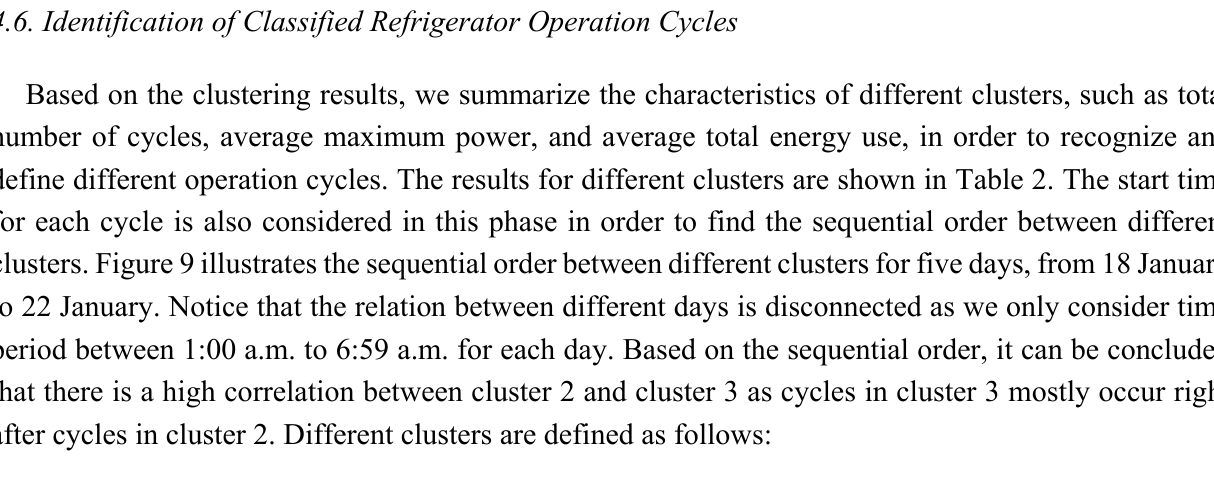
Table 2. Energy performance summary of different